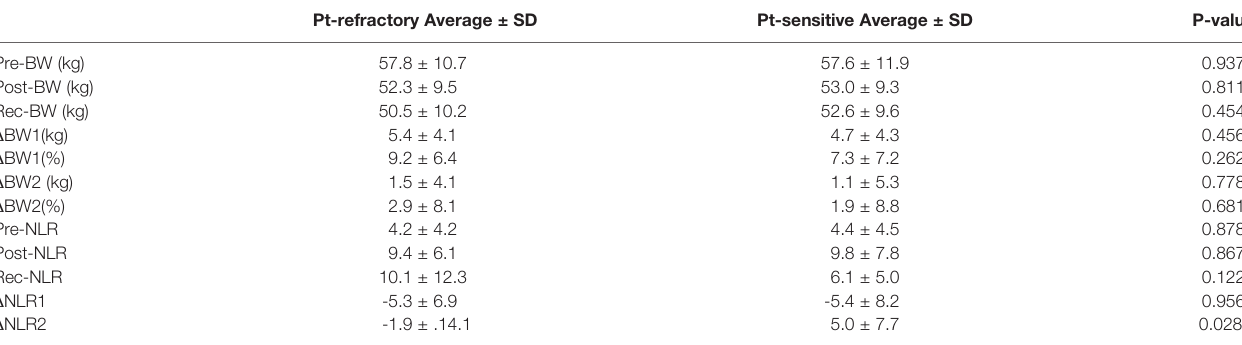
TABLE 3 | BW and NLR before de fi nitive therapy, after de fi nitive therapy, and at the detection of recurrence.